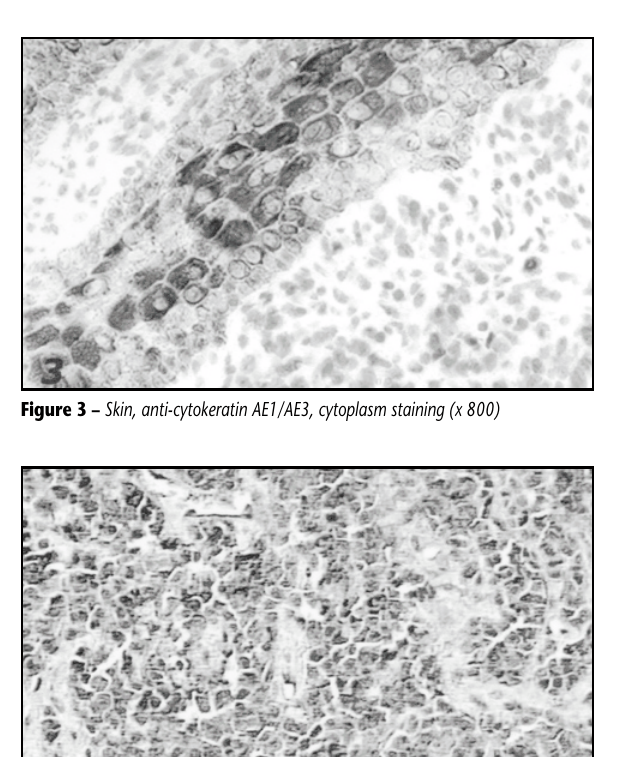
Figure 2 – Neuroendocrine carcinoma, anti-neuron specific enolase (NSE), cytoplasm staining (x 800)